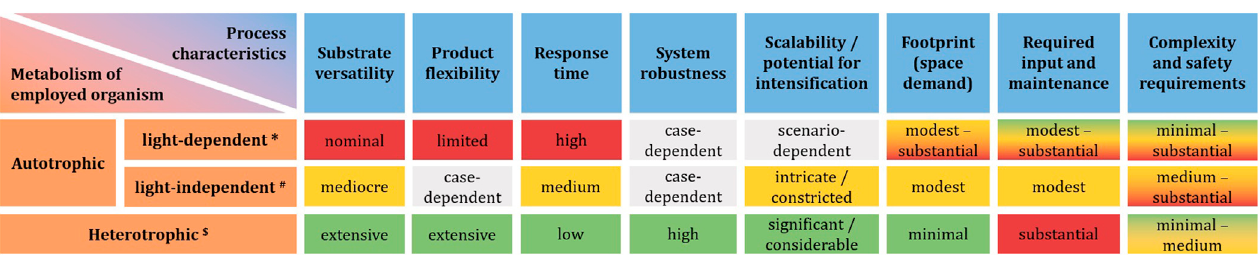
TABLE 1| Qualitativecomparisonofprocessesbasedonthetype ofmetabolismofmicrobialcellfactoriestosupportaninitialfootholdonMars inanISRUscenario.Limited to production of basic compounds (small-, as well as macromolecules but excluding biomanufacturing i.e., physical structures) with pure cultures. Green shading represents an advantage, red shading a disadvantage, yellow a draw. Gray shading indicates non-decision due to great diversity of process factors preventing categorization. It should be noted that the different decision factors do not necessarily have the same weight.